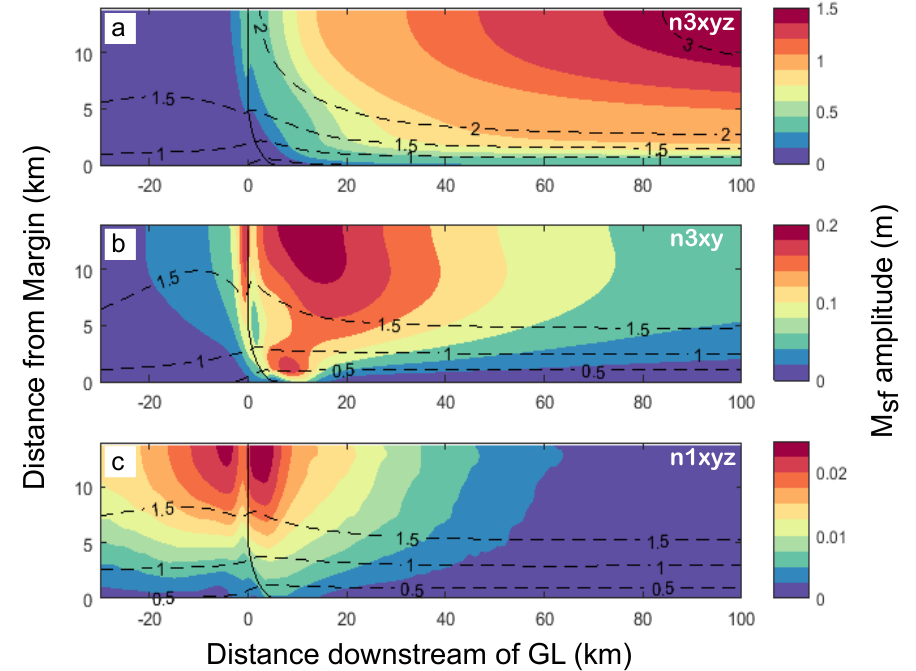
Figure 4. Plan view of M sf amplitude in horizontal surface ice displacements, calculated with the full-Stokes viscoelastic model for the three experiments described in Sect. 5. Panel (a) shows experiment n3xyz, i.e. the standard case with n = 3 and bending all along the sidewall boundary. Panel (b) shows experiment n3xy in which the ice only bends at the x = 0 GL. Panel (c) shows the n1xyz experiment, for which n = 1 but with the same BCs as panel (a) . Dashed black lines are contours of downstream mean surface ice velocity, and solid black lines show the GL position. Note the differences in colour scale between each panel.